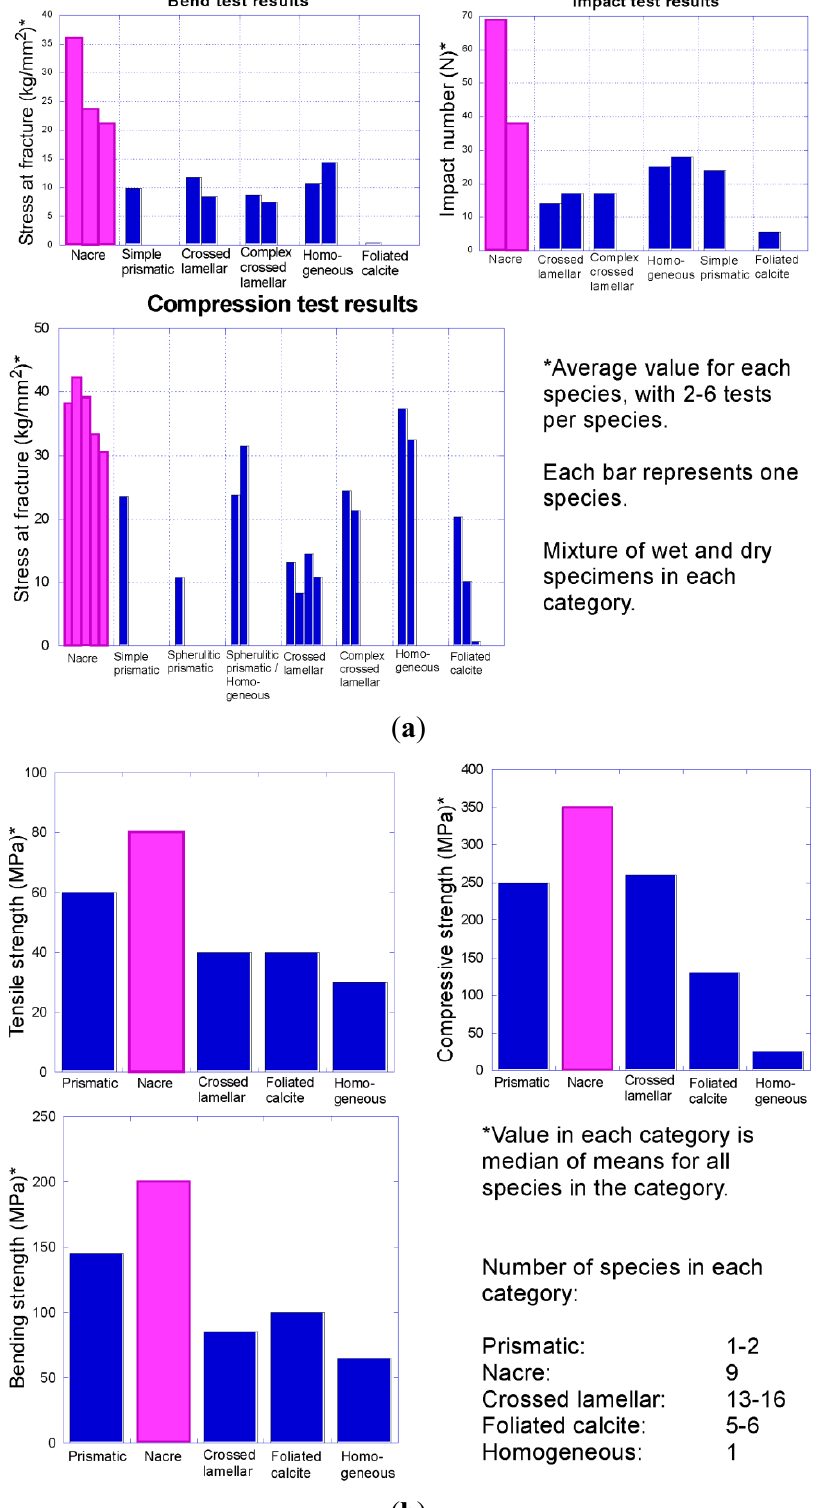
Figure 11. Compilation of data on comparative strength of molluscan shell microstructures. Note that nacre (pink) consistently outperformed all other shell microstructures in tests of toughness in these two separate studies: ( a ) Fracture resistance of different bivalve shell microstructures (data from Taylor and Layman [5]); ( b ) strength of different mollusc shell microstructures (data from Currey